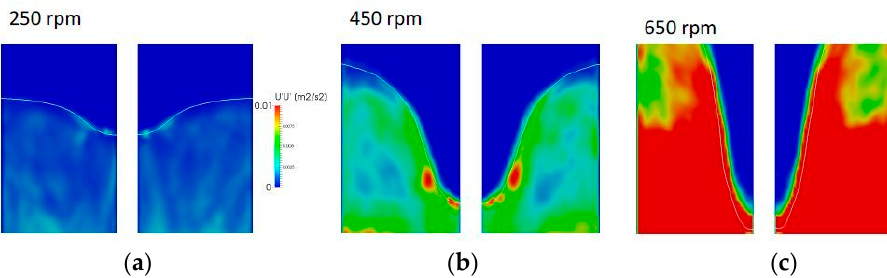
Figure 7. Predicted distribution of the mean square velocity in water near the vortex surface. ( a ) 250 rpm, ( b ) 450 rpm, ( c ) 650 rpm.